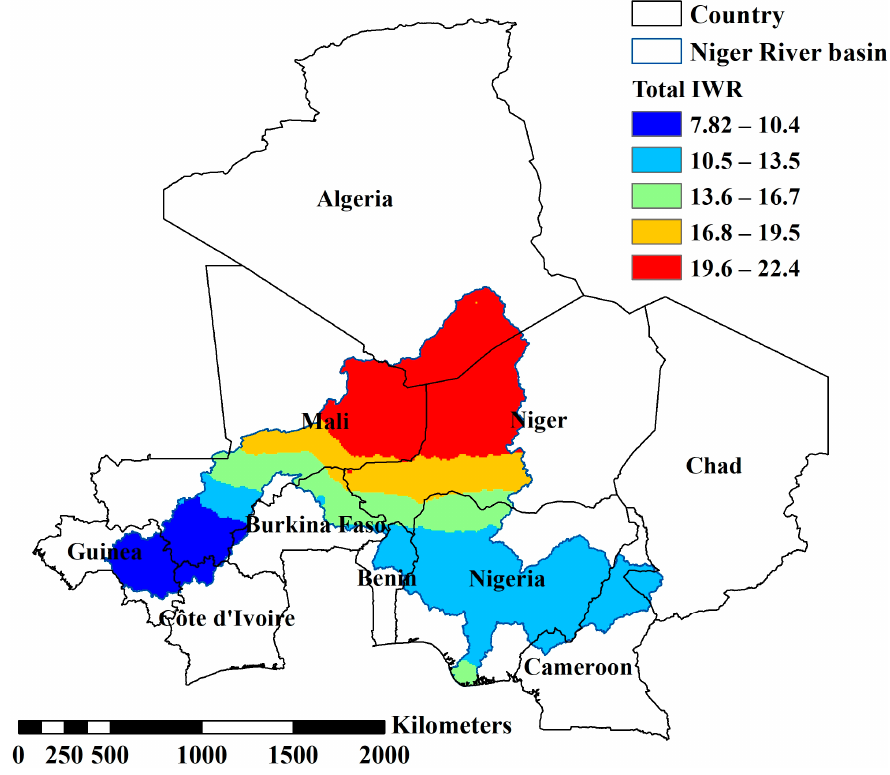
Figure 8. IRW under ECHAM. It shows the global irrigation water requirements in different countries in the basin under the RCP 8.5.